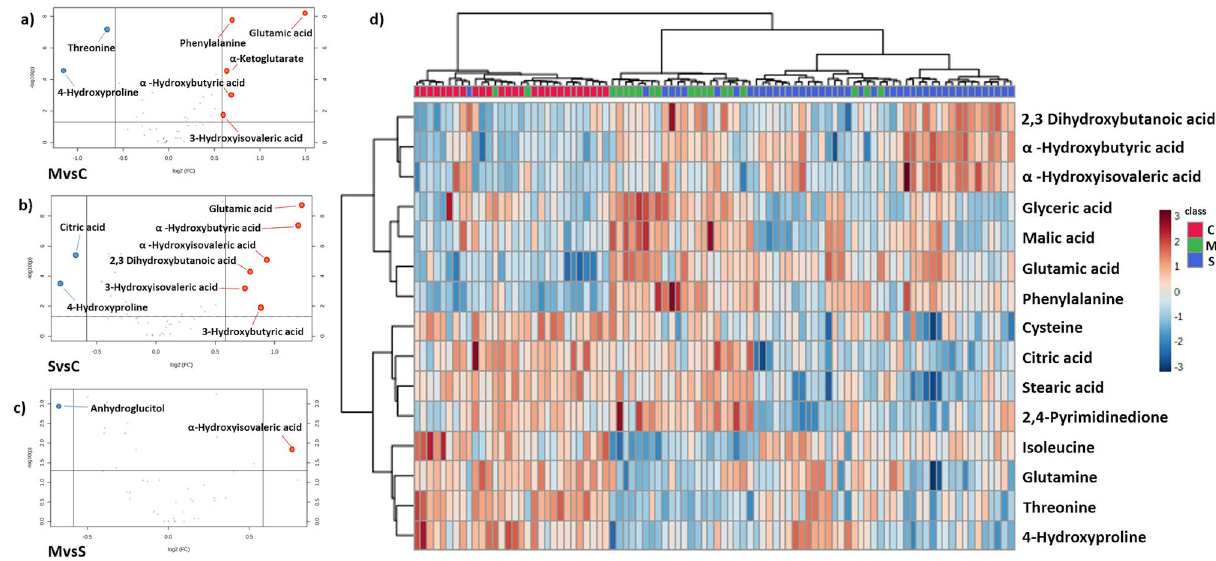
Figure 1. Changes in serum metabolites of controls vs COVID-19 patients. Volcano plots of metabolites that increase (red) or decrease (blue) in ( a ) mild COVID-19 versus controls, ( b ) severe COVID-19 vs controls and ( c ) severe versus mild COVID-19. Cut off fold change > 0.5, p value < 0.05. ( d ) Heatmap visualization and clustering analysis of differential metabolites among controls (C), mild (M) and severe (S) COVID-19 patients. Only the 15 metabolites with the lowest p values (by ANOVA) are